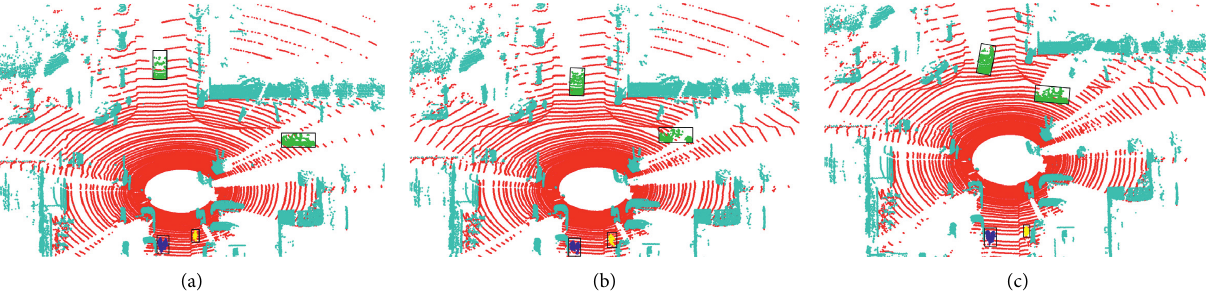
Figure 2: Top view of the scene with moving clusters. (a) Frame 149, (b) Frame 157, and (c) Frame